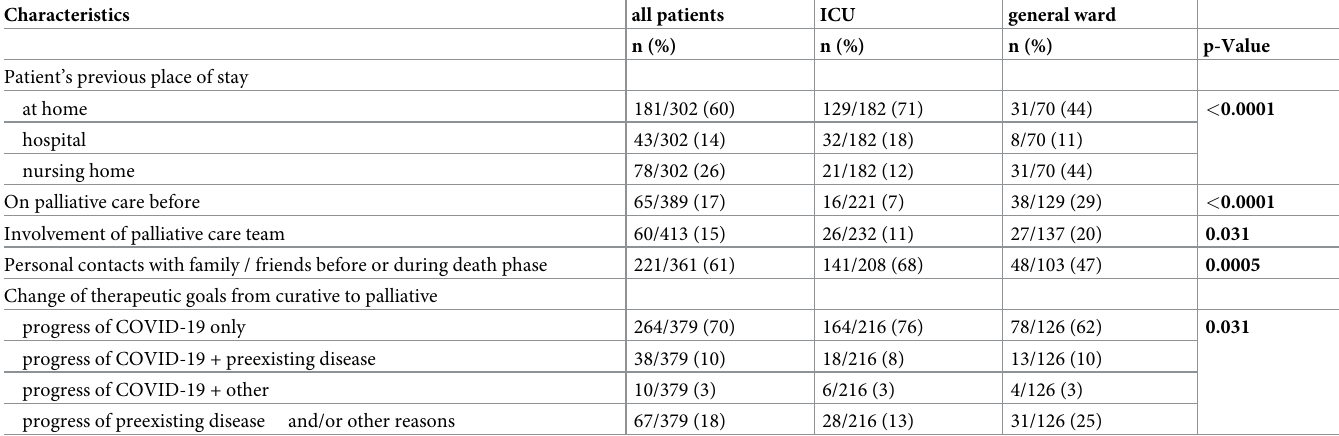
Table 2. Management of patients dying with SARS-CoV-2 infection treated at ICU or general ward.